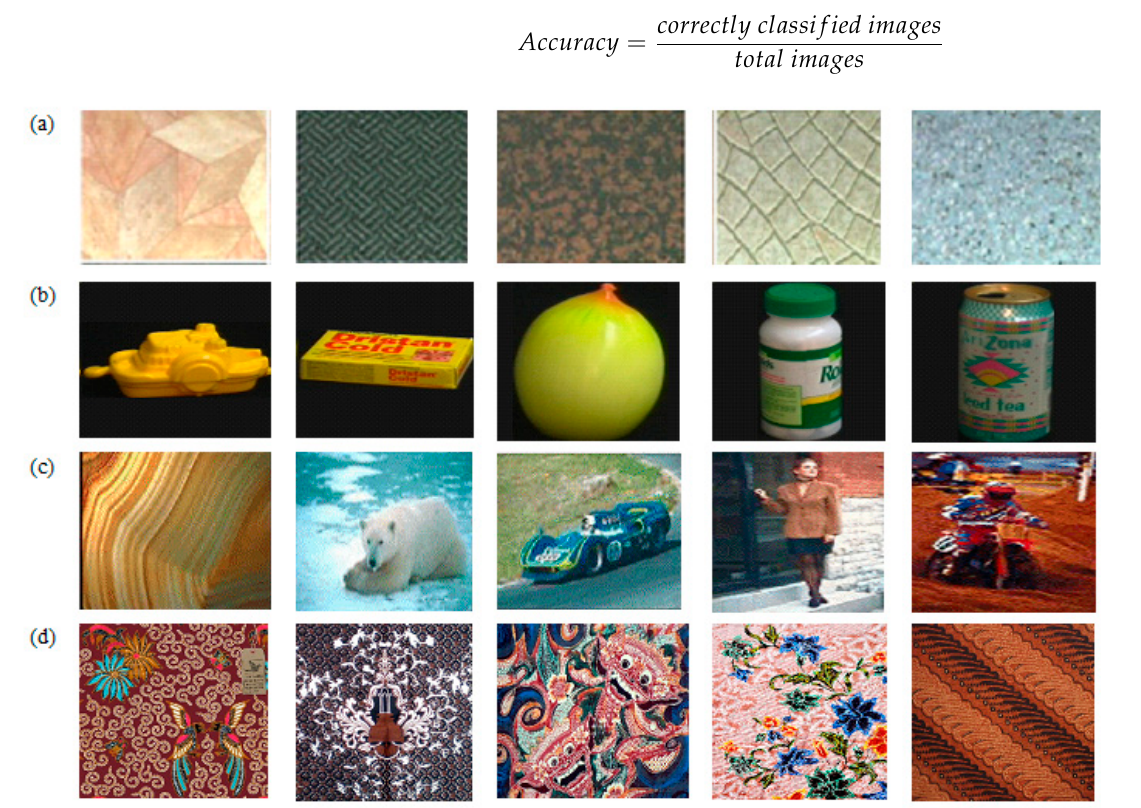
Figure 2. Sample images from each dataset. ( a ) Outex, ( b ) Corel10K, ( c ) Coil100 and ( d ) Batik.